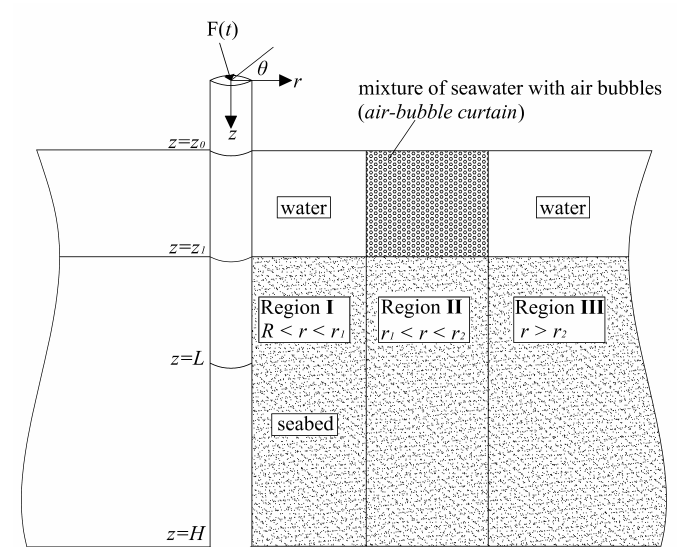
Figure 14. Model proposed by Tsouvalas and Metrikine [188] to treat the case of a system which includes an air bubble curtain, i.e., Region II. Reprinted from Tsouvalas, A.; Metrikine, A.